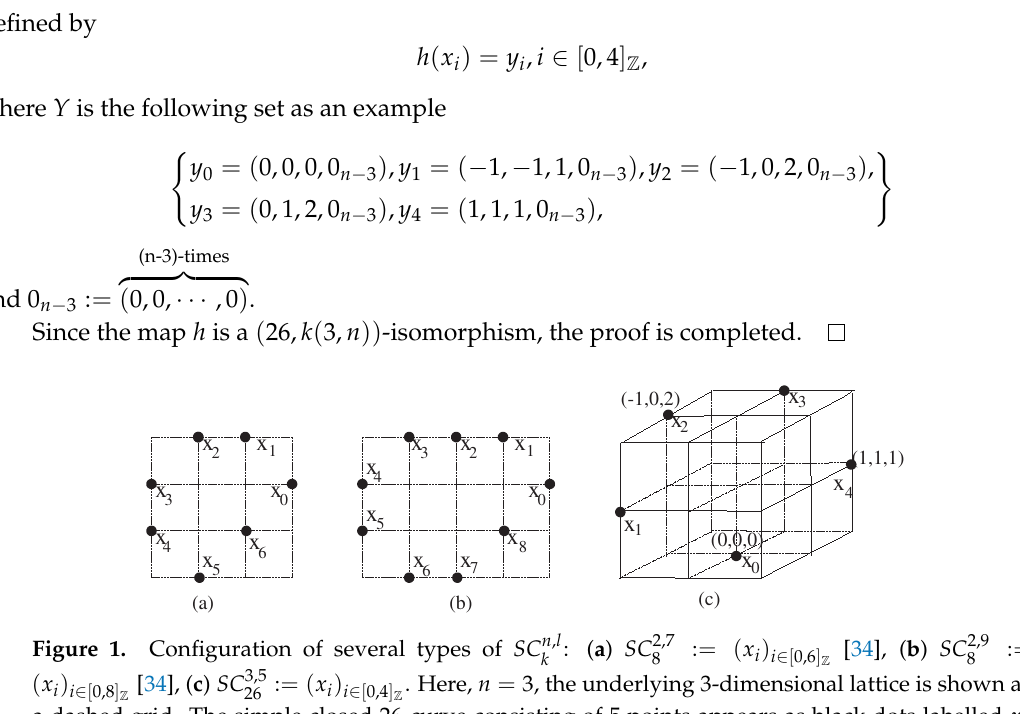
a dashed grid. The simple closed 26-curve consisting of 5 points appears as black dots labelled x 0 through x 4 . Indeed, there are several shapes of SC 3,5